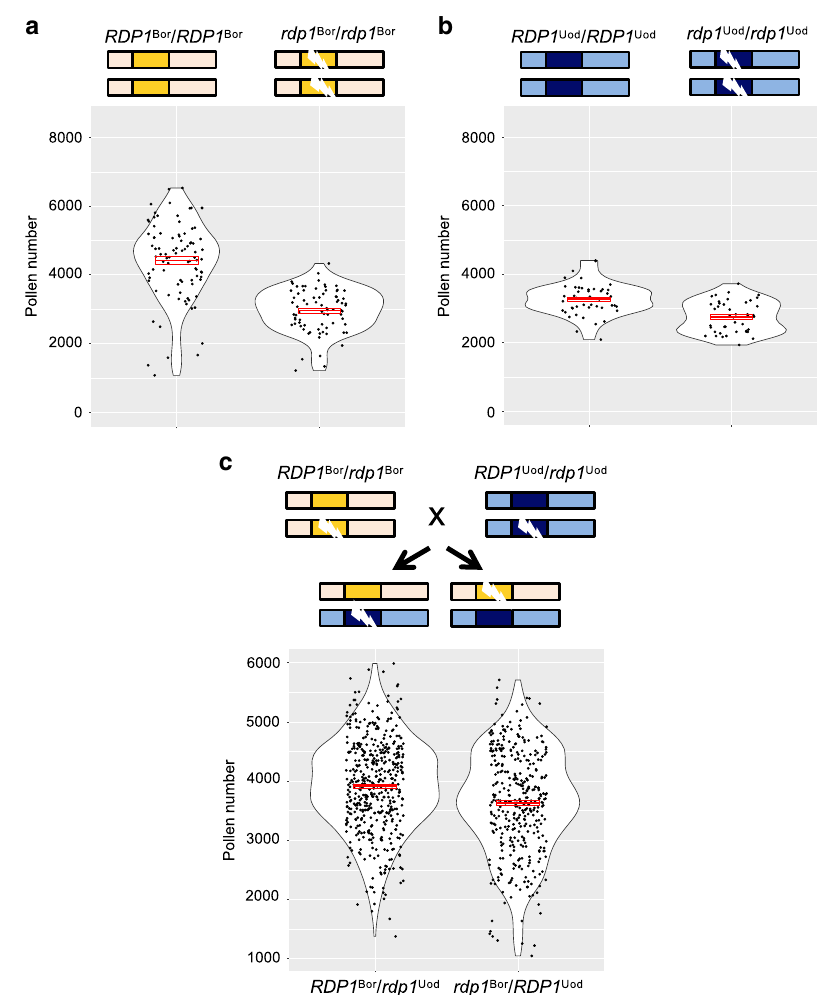
Fig. 3 Quantitative complementation test of the RDP1 gene. Violin plots with means and standard errors of means indicated by red bold bars and boxes, respectively. a , b Pollen number differences between wild-type and homozygous plants of a frameshift allele generated by the CRISPR/Cas9 technique in the Bor-4 background ( a Numbers of fl owers pollen-counted: RDP1 Bor /RDP1 Bor , N = 89; rdp1 Bor /rdp1 Bor , N = 77) and in the Uod-1 background ( b Numbers of fl owers pollen-counted: RDP1 Uod /RDP1 Uod , N = 47; rdp1 Uod /rdp1 Uod , N = 43) (same data sets with Fig. 2h). c The difference in the effect on pollen number by two natural alleles, RDP1 Bor and RDP1 Uod . Pollen number of plants with RDP1 Uod was signi fi cantly lower than that of plants with RDP1 Bor (nested analysis of variance; P = 4.85 × 10 – 8 ; Numbers of fl owers pollen-counted: RDP1 Bor /rdp1 Uod , N = 468 from 26 individuals; rdp1 Bor /RDP1 Uod , N = 368 from 20 individuals). The two alleles were compared in the heterozygous state with a frameshift CRISPR/Cas9 allele, with otherwise identical genetic backgrounds. F 1 plants were obtained from the cross of two heterozygotes, RDP1 Bor /rdp1 Bor and RDP1 Uod /rdp1 Uod . Source data are provided as a Source Data fi